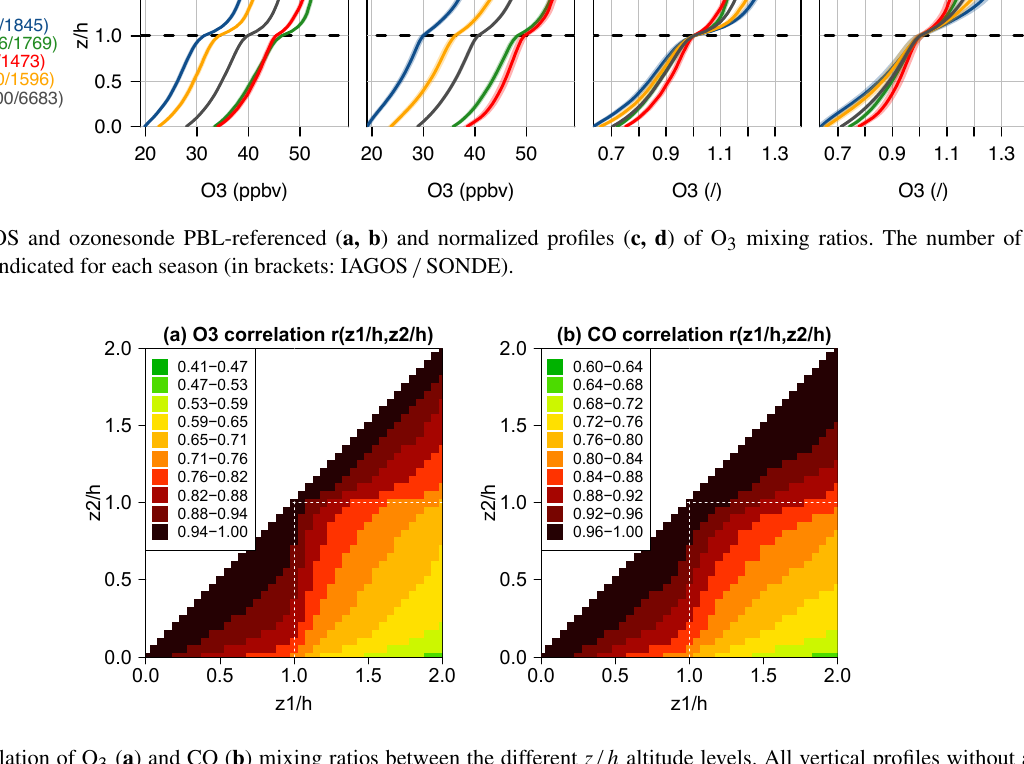
Figure 15. Correlation of O 3 ( a ) and CO ( b ) mixing ratios between the different z/h altitude levels. All vertical profiles without any data gaps are taken into account. The correlation matrix is symmetric by